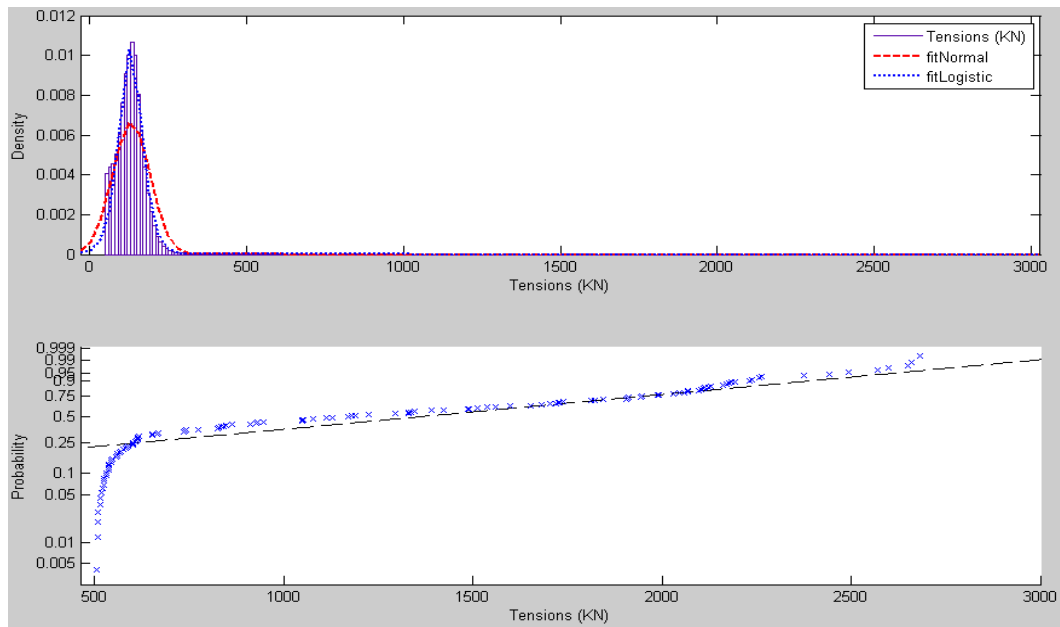
Figure 6. An example of distributional fits to the mooring loads (test 7020). Upper panel: all data except pretension values (Tensions ≥ 50 KN) with fitted Normal and Logistic distributions. Lower panel: extreme value distribution showing a reasonable fit to the tail (Tensions ≥ 500 KN).